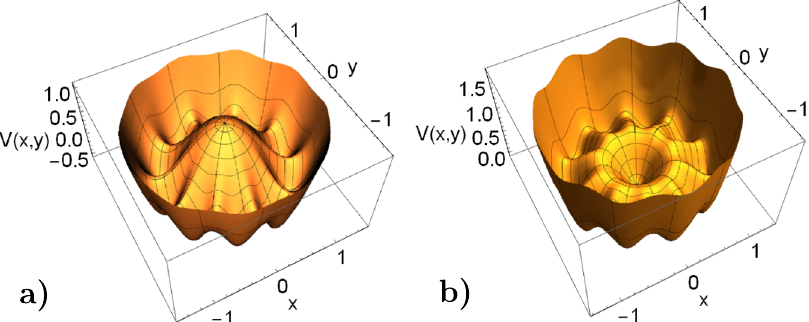
Fig. 6 Mexican-hat-type trap potential. a Realization of the ring lattice for d = 10 by a Mexican-hat-potential. b Realization of the wheel lattice for d = 10 by a Mexican-hat-like potential with a local well at its center. Loading hard-core bosons into the potential landscape in ( a ) and creating a local well as shown in ( b ) generates a crossover from quasi to complete Bose – Einstein